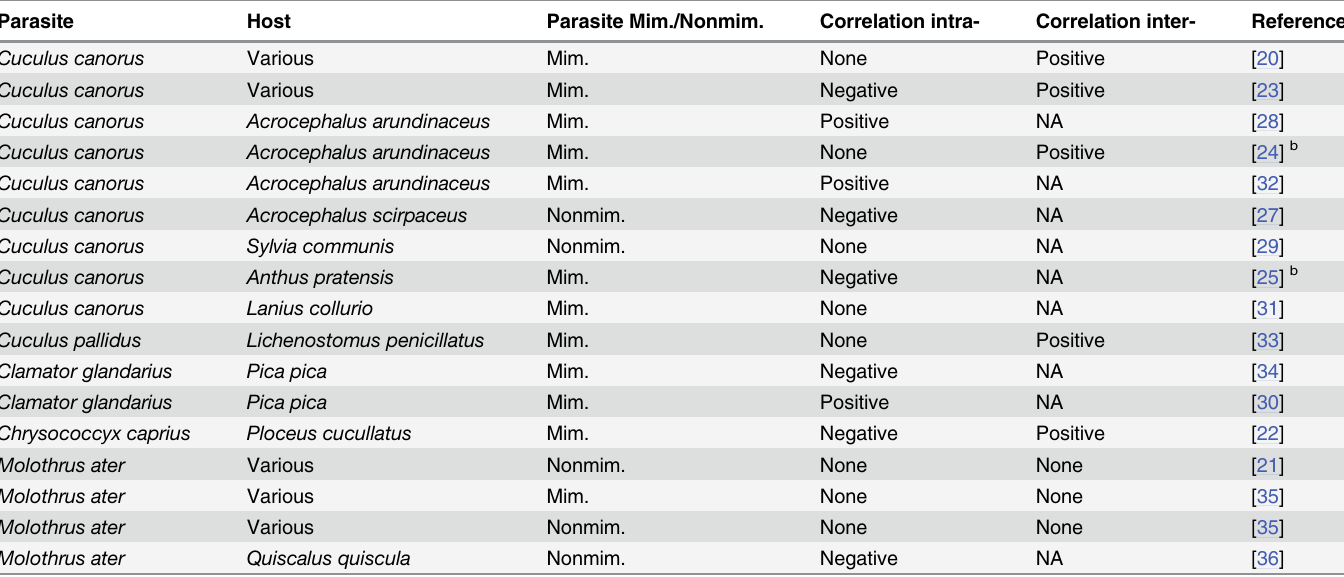
Table 1. Summary of published studies using observational tests of the relationship between intraclutch egg appearance variability and rejection rate by hosts of obligate brood parasitic birds. a Parasite